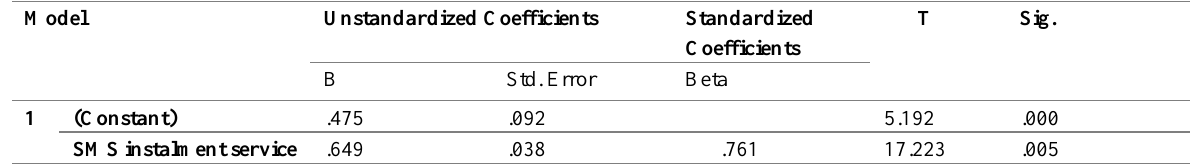
Table 2: Regression Coefficients of The Effectiveness of SMS Customer Service Platforms on Customer Satisfaction Model